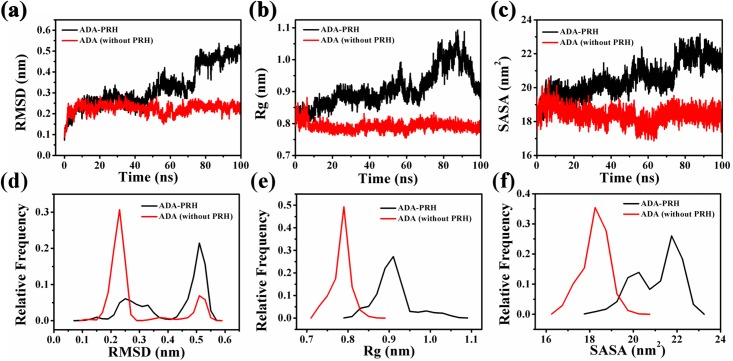
Structure stability of T57 to A73 of the two systems.(a) RMSD; (b) Rg; and (c) SASA of residues T57 to A73 in the 100 ns simulations. (d) Relative frequencies of RMSD; (e) Rg; and (f) SASA of residues T57 to A73.